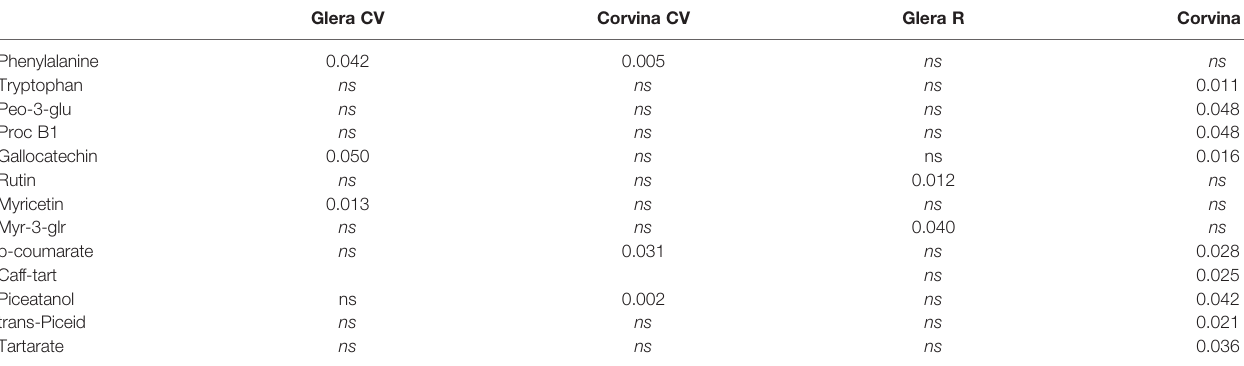
TABLE 3 | Metabolites found to be signi fi cantly affected by soil factor when separating phenological stage and